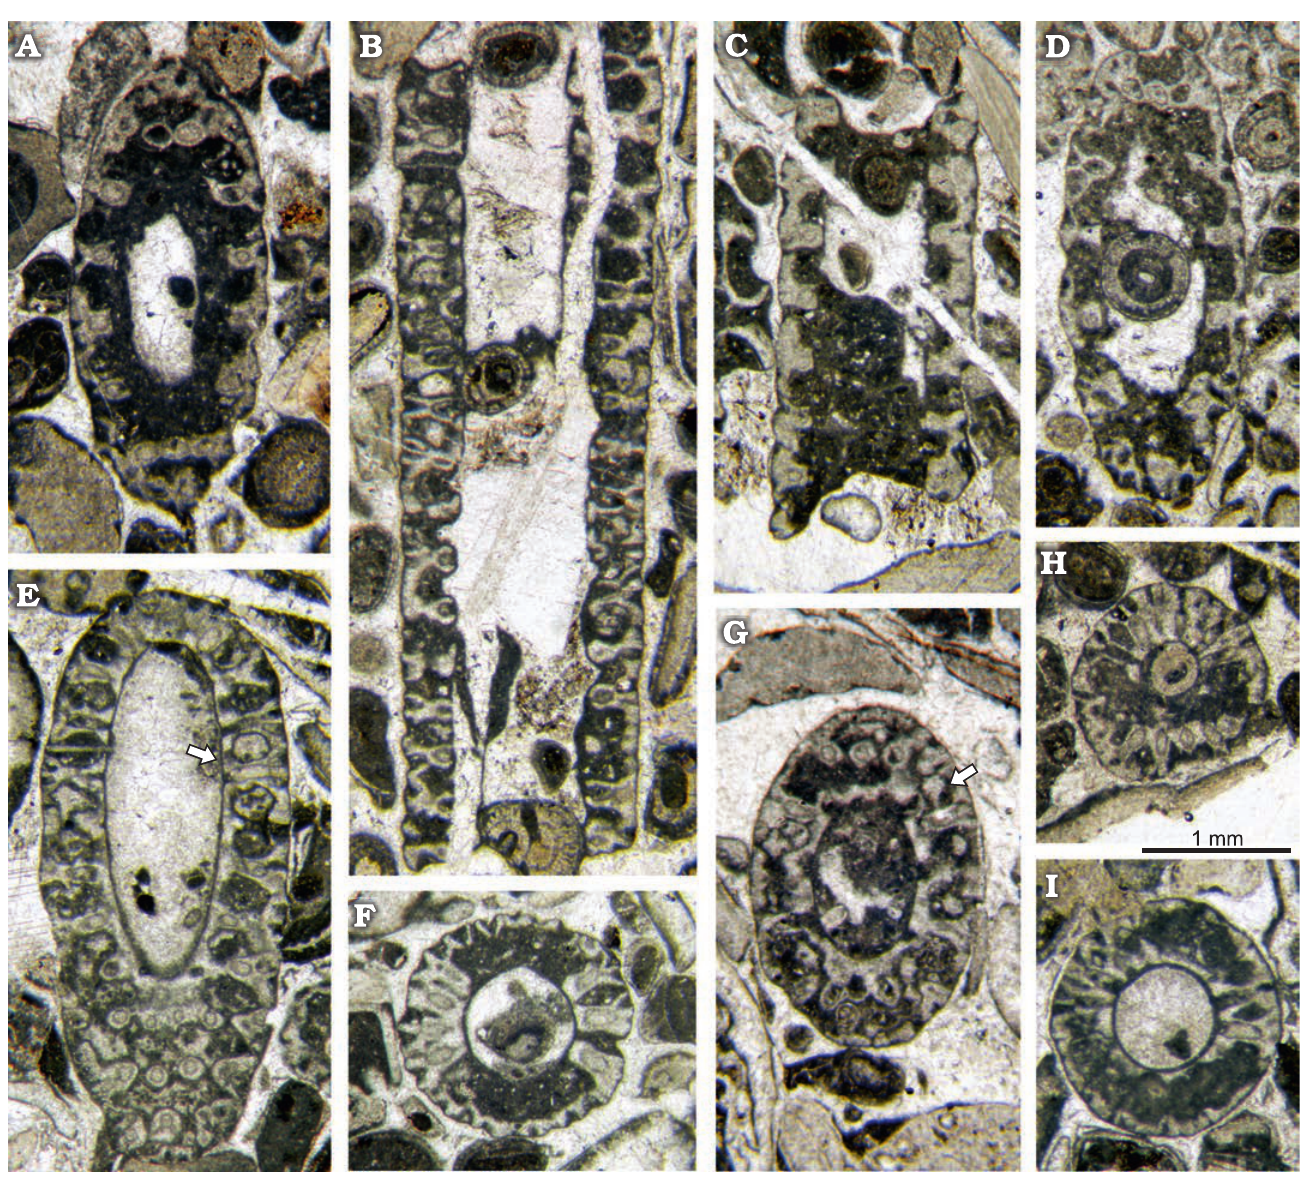
Fig. 6. Dasycladalean alga Chinianella ellenbergeri (Lebouché and Lemoine in Granier and Deloffre, 1994) Granier, Masse and Berthou, 1994, emend. nov., upper Sinemurian (Lotharingian), Canders, 2.4 km E of Fontcaude, (S France). A . LM-DiSTAR/BA.577.16, n. 065, oblique section of a weakly mineralized specimen showing intusannulation. B . LM-DiSTAR/BA.577.21, n. 114, axial section, notice the irregular inner contour. C . LM-DiSTAR/ BA.577.24, n. 117, axial section of a weakly mineralized specimen showing intusannulation. D . LM-DiSTAR/BA.577.28, n. 126, oblique section of a weakly mineralized specimen with intusannulation. E . LM-DiSTAR/BA.577.4, n. 003, oblique section of a strongly mineralized specimen, note the regular contour of the inner cavity, interverticillar cavities sometimes communicate with the central cavity by mean of a small pore (see arrow). F . LM- DiSTAR/BA.577.9, n. 018, oblique section showing the annular and vertical channels. G . LM-DiSTAR/BA.577.10, n. 024, transverse-oblique section, a possible gametophore looks attached to primary lateral (see arrow). H . LM-DiSTAR/BA.577.8, n. 014, transverse-oblique section showing the annular and vertical channels. I . LM-DiSTAR/BA.577.15, n. 054, transverse-oblique section, note the annular channel with scalloped surfaces in the proximal sleeve and the calcareous shield,